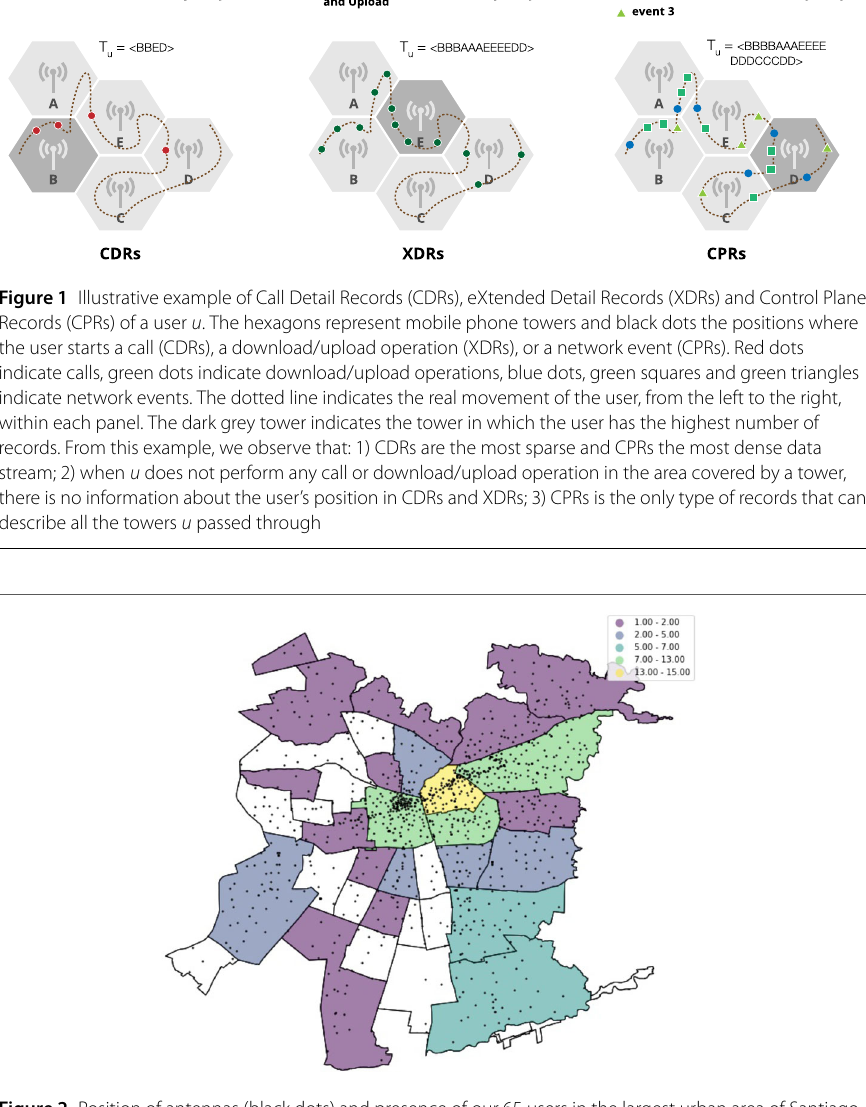
An XDR is a tuple ( n , t , A , k ); in contrast to CDRs, there is only one antenna A involved, n is the caller’s identifier, t is a timestamp of when the record is created and k is the amount of downloaded information (in kilobytes). Finally, a CPR is a tuple ( n , t , A , e ), where each e ∈ E is an “event” of the network. There are many possible control plane events, such as “handovers” (when a new antenna is pushed on the device), the “(re-)activation” of a phone,